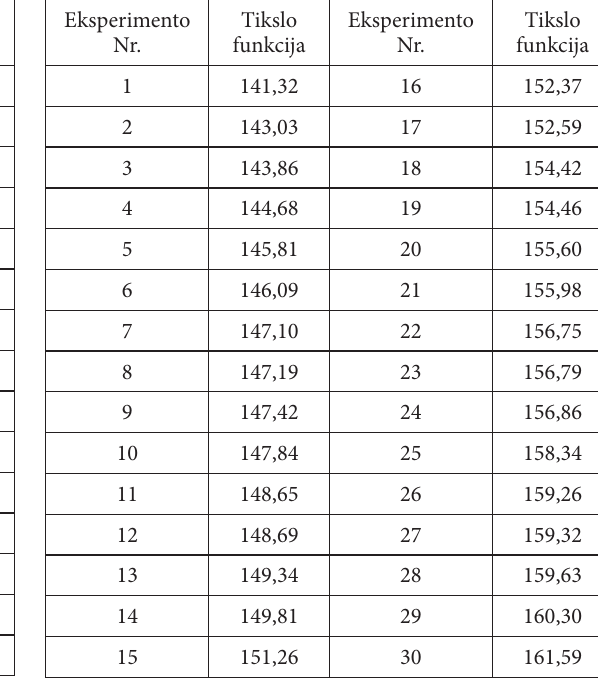
Table 2. Results for task of moments minimization for 10 pole grillage